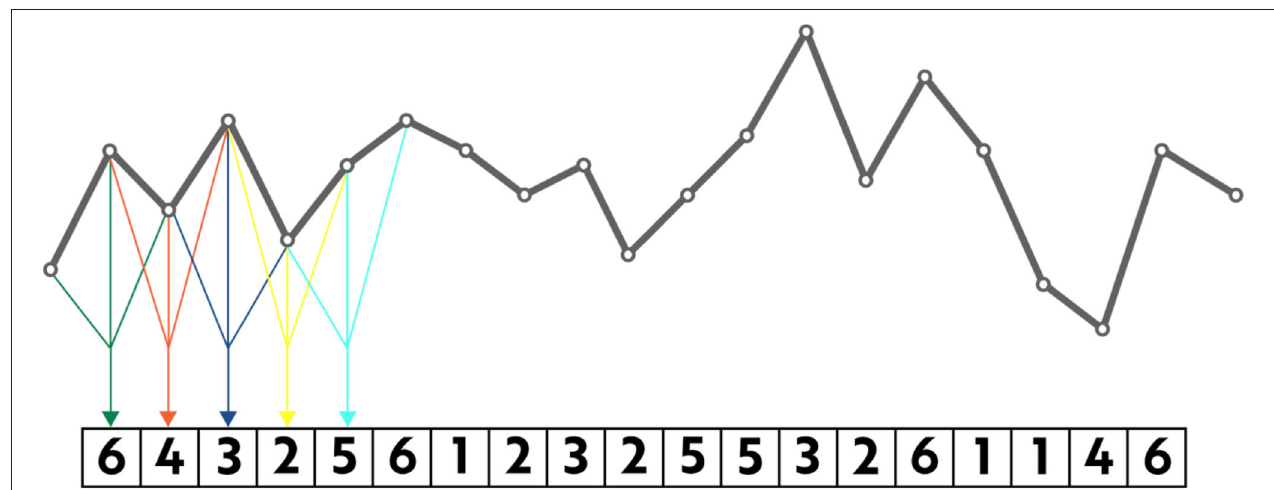
FIGURE 3 | Construction of a motif series from a time